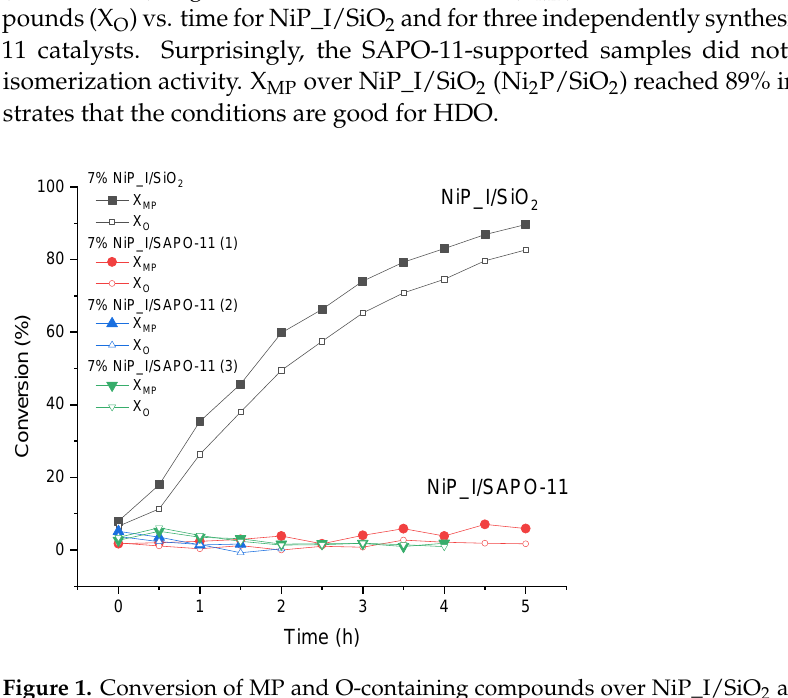
Figure 1. Conversion of MP and O-containing compounds over NiP_I/SiO 2 and NiP_I/SAPO-11 catalysts in an autoclave (290 ◦ C, 3 MPa, V H2 = 100 mL/min, 500 RPM, m cat = 1 g). SAPO-11 is a microporous material (Table S1) and micropores as well as mesopores can be blocked by excess P. For example, it was shown that Ni/zeolite catalysts have a larger surface area than Ni(H 2 PO 4 ) 2 /zeolite catalysts [51]. Indeed, S BET significantly de- creased after phosphide preparation (29 m 2 /g, Table S1) and after reaction (8 m 2 /g, Table S1). The initial Ni/P ratio was 1/2. During TPR at high temperatures, P can form volatile P-containing compounds (PH 3 and products of its interaction with H 2 O) [52,53]. However, excess P can also remain on the support surface after TPR in the form of unreduced phos- phates (PO x ) (H n PO 4(3 − n)− , P 2 O 74− , and (PO 3− ) n ) [36,54,55]. To avoid blocking the SAPO-11 pores, we tested 3 wt.% NiP_I/SAPO-11 (TPR at 450 °C). To verify whether SAPO-11 is a reliable support, we tested 3 wt.% Ni/SAPO-11. Con- version values of X MP = 75% and X O = 58% were reached over Ni/SAPO-11 after 5 h of